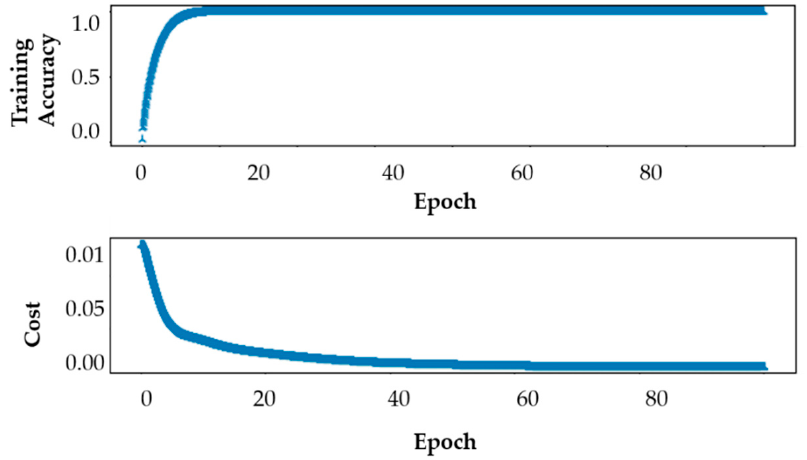
Figure 7. The accuracy ( top ) and cost function performance ( bottom ) of VGGNet during training.